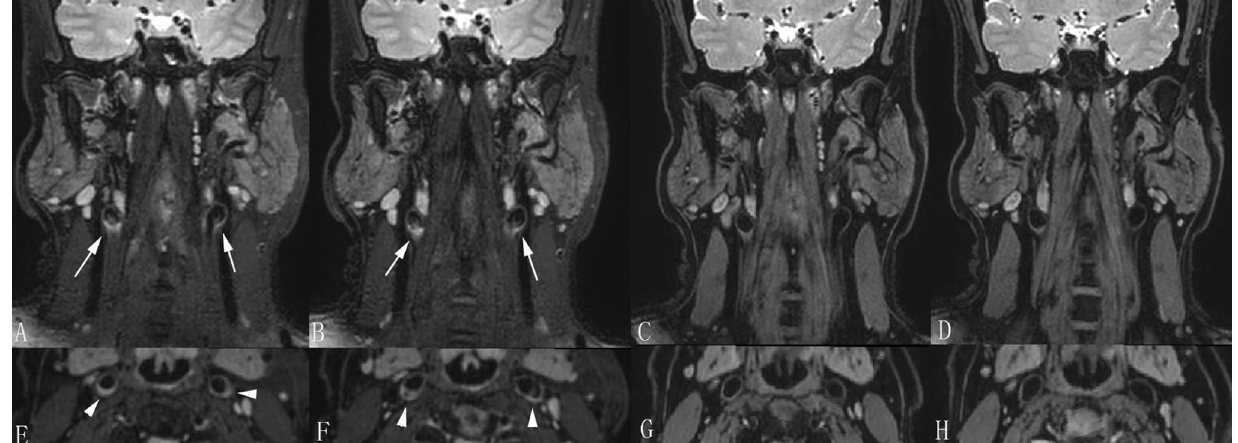
Figure 5. Examples of residual flow artifacts at the carotid bifurcation. ( A , B , E , F ) Presence of residual flow artifacts at the carotid bifurcation (arrows on the coronal plane and arrowheads on the reconstructed transverse plane) presented on 3D T2-weighted fast field echo (3D_T2_SPACE). Note that the artifacts may lead to overdiagnosis of plaques. ( C , D , G , H ) No residual flow artifacts at the carotid bifurcation were presented